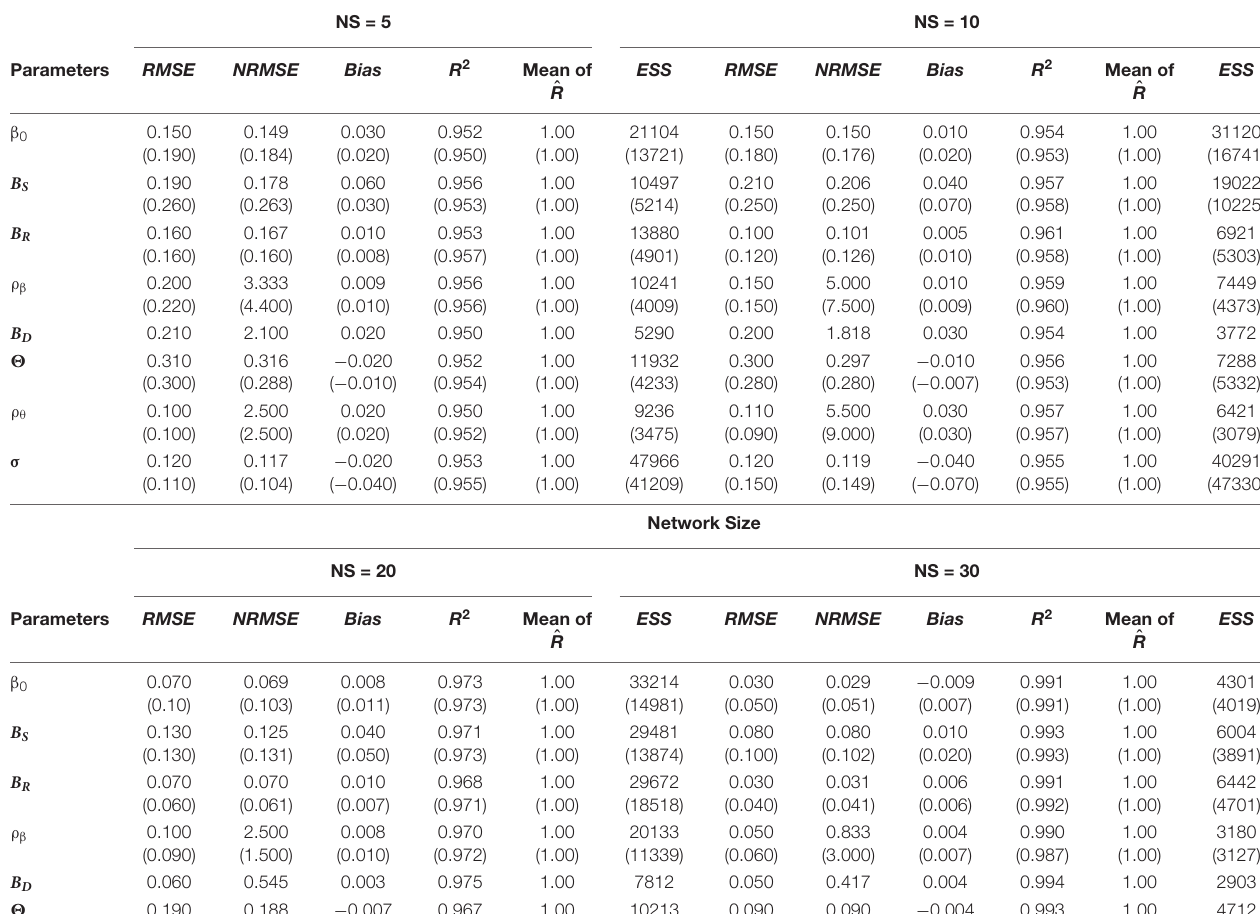
TABLE 5 | Root-mean-squared error ( RMSE ), normalized root-mean-squared error ( NRMSE ), bias, and coefficient of determination ( R 2 ) of parameter recovery, convergence diagnosis index ( ˆ R ) , and effective sample size ( ESS ). Network Size (NS) NS =